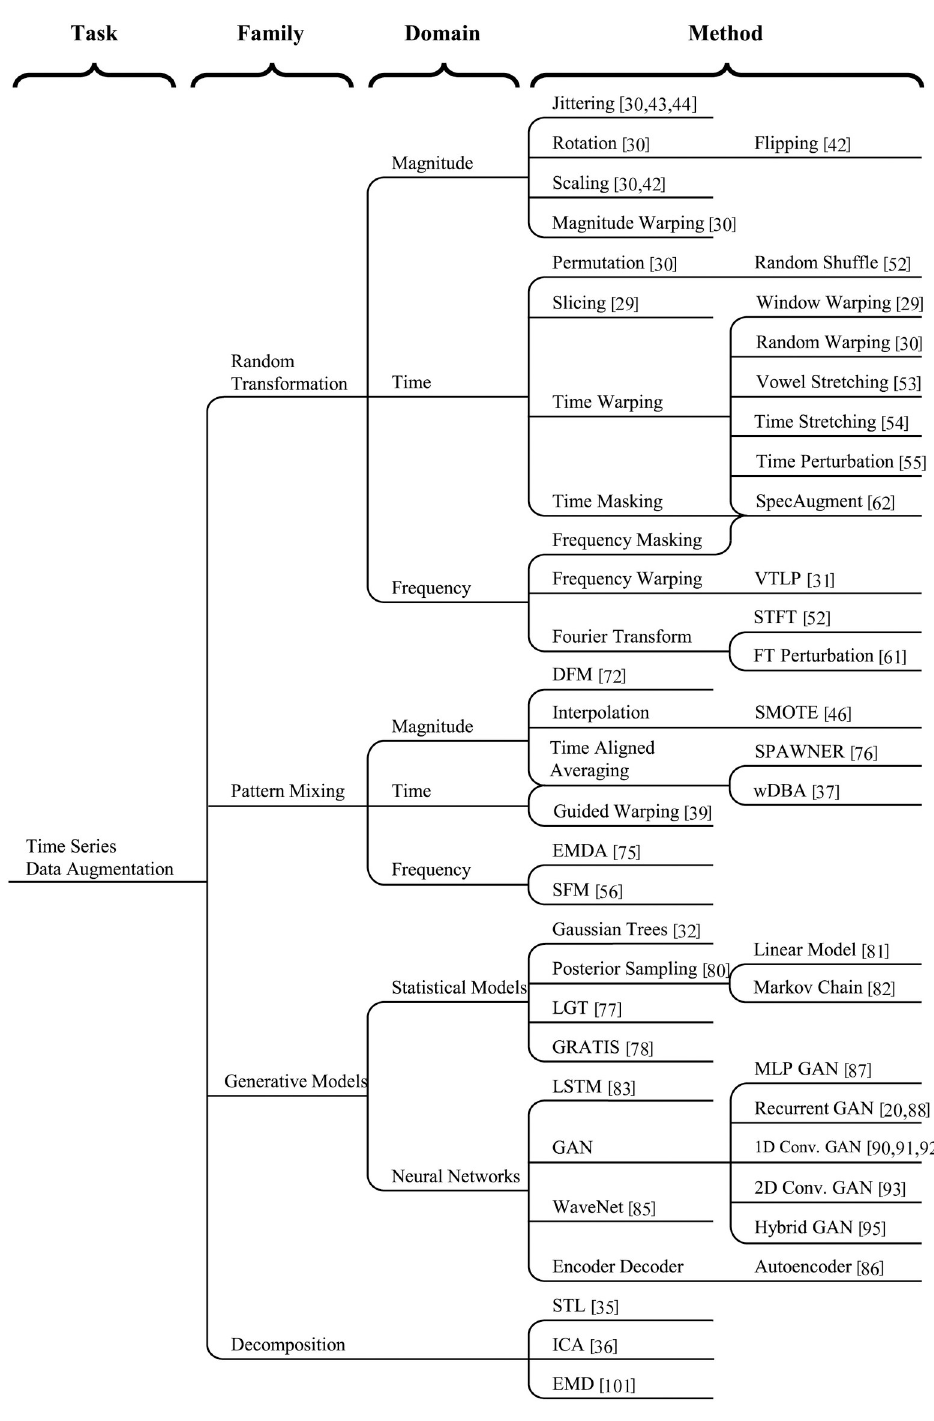
Fig 2. Taxonomy of time series data